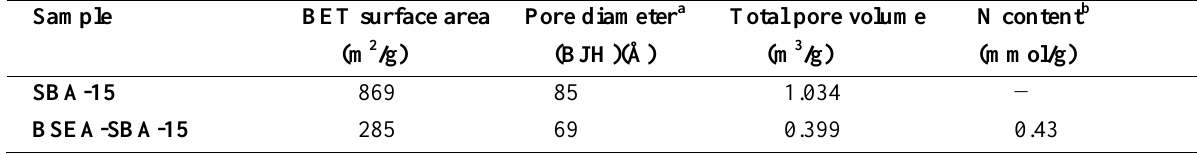
Table 1. Textural and physicochemical properties of BSEA-SBA-15